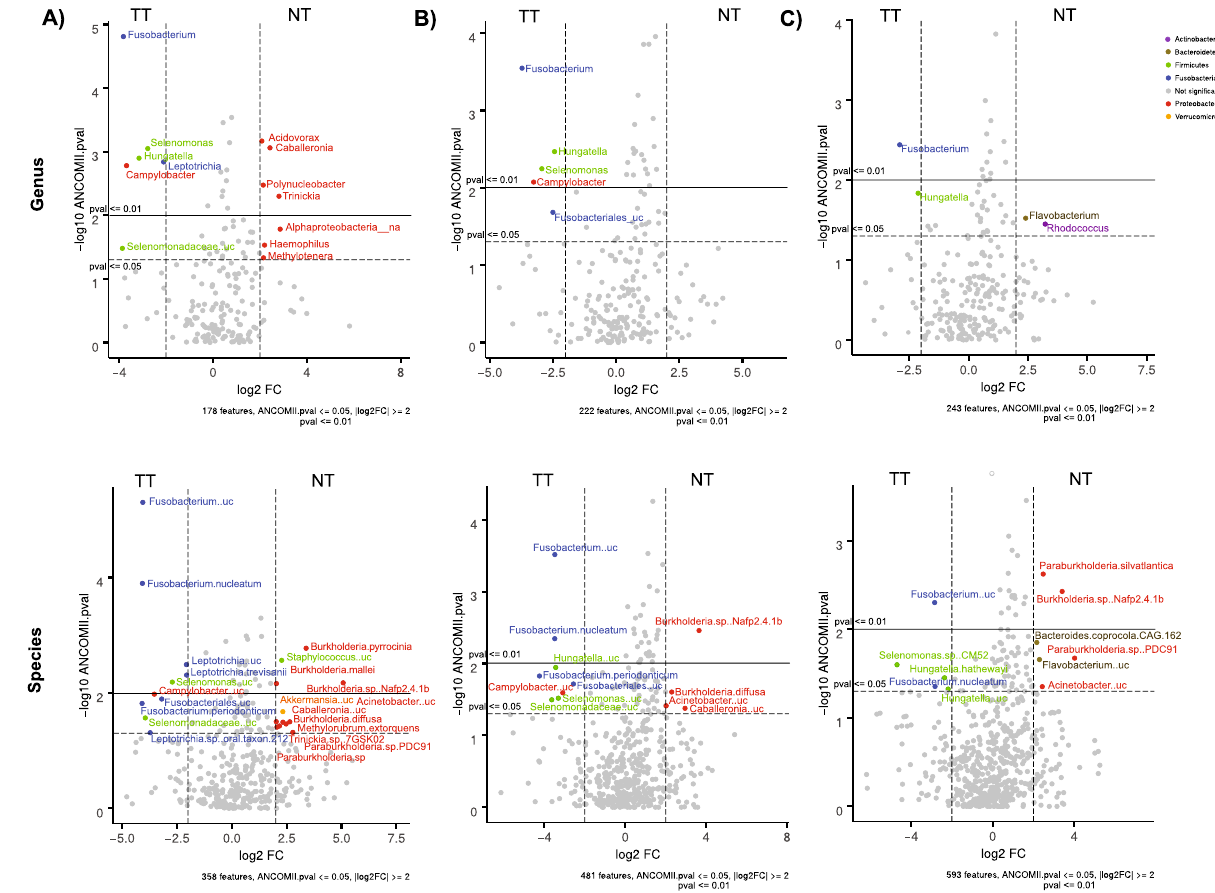
Figure 4. Volcano plots showing the differential abundance of taxa, at genus (top) and species (bottom)level, identified using ANCOMII analysis, between normal mucosa and tumor tissue. Three subsets of samples were used for this analysis: ( A ) all samples, ( B ) only samples with more than 200 reads in both samples in the pair, and ( C ) only samples with more than 400 reads in both samples in the pair. Features are sorted by p value. Significant dots showing features above p -value < 0.05 (dashed line) and log fold change (log2FC) > = 2, | p -value < 0.01 (solid line) | log2FC ≥ 2, are colored according to the phylum they belong